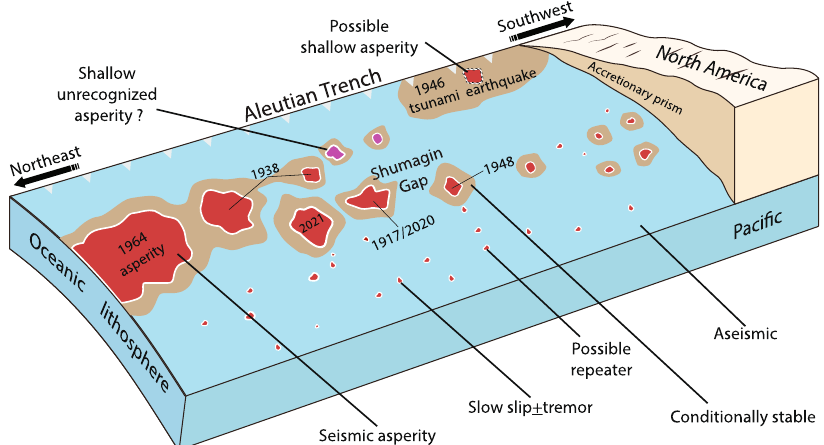
Fig. 7 Summary schematic of the tectonic setting and slip behaviors of the plate interface along the Aleutian subduction zone. The size of permanent core seismic asperities decreases from east to west and the size of conditionally stable and creeping areas